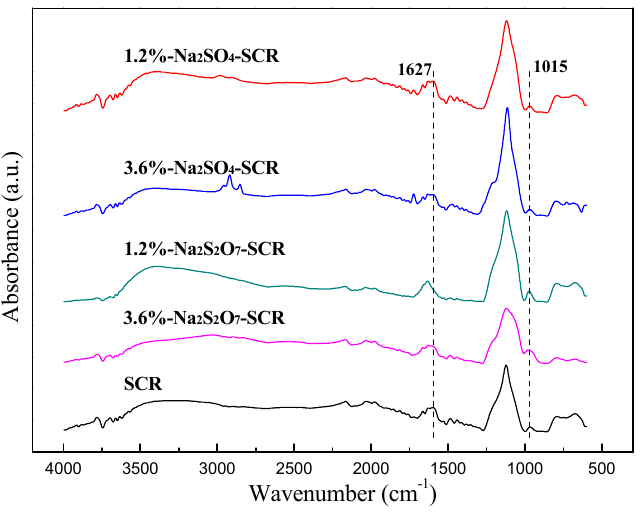
Figure 12. FT-IR spectra of the catalysts.